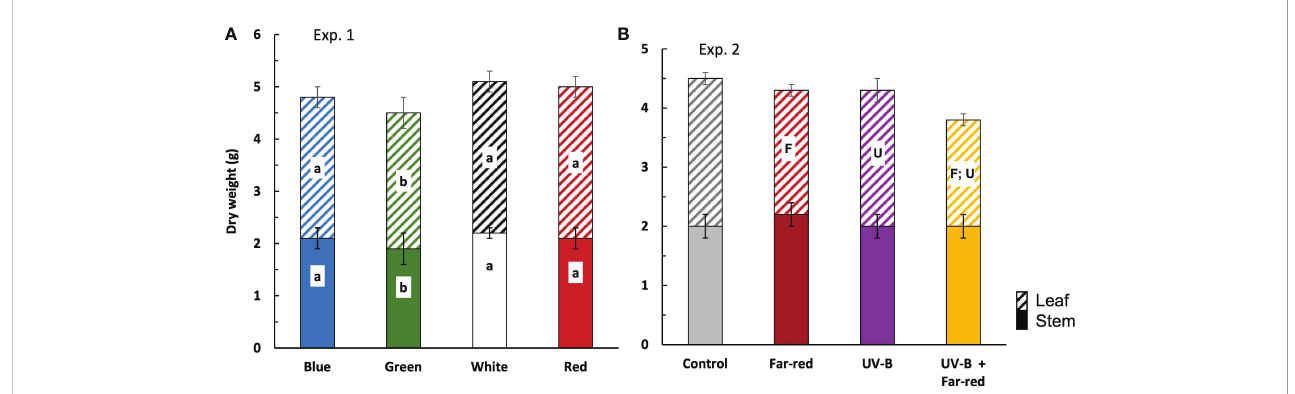
FIGURE 4 Plant dry weight at fi nal harvest in treatments of supplemental radiation within (A, Exp. 1) and outside (B, Exp. 2) the range of PAR (values are mean ± s.e.; n = 4, with 15 plants in each statistical replicate). Solid bars are stem dry weight. Dashed bars are leaf dry weight. Details on the treatment abbreviations can be found in Figure 1. In panel (A) , letters indicate signi fi cant differences ( p < 0.05). In panel (B) , “ F ” and “ U ” respectively indicate a signi fi cant effect of far-red and UV-B ( p <